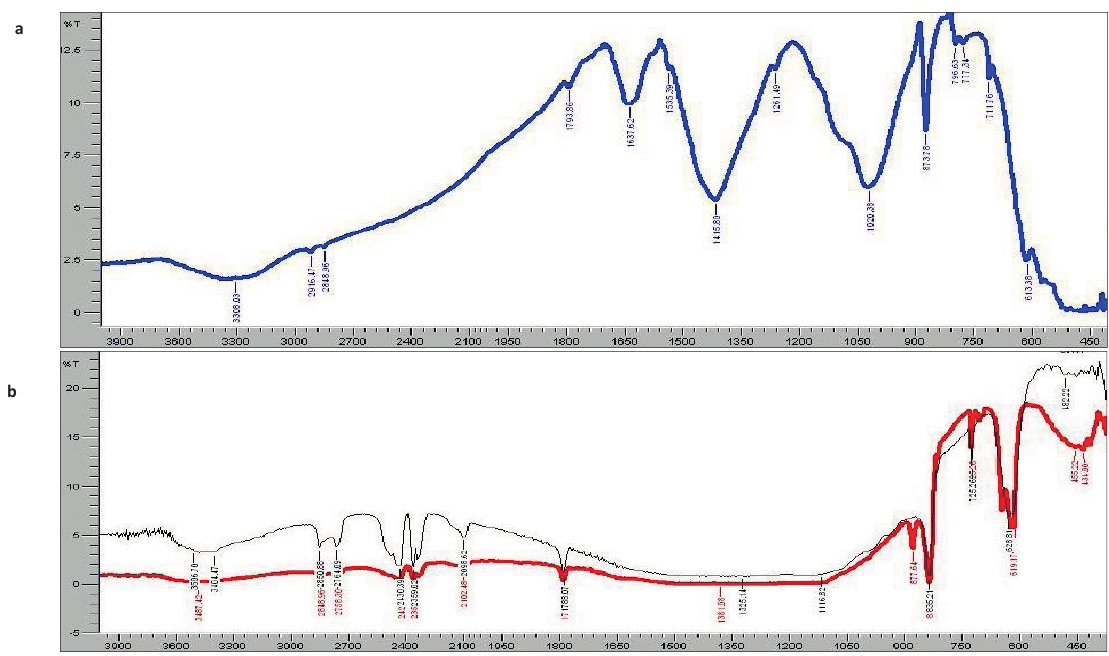
Fig. 3 Figure 3: a) FTIR spectrum P. cerasifera fruit extract and b) FTIR spectra overlay of P. cerasifera fruit extract mediated ZnO nano falcate calcined at 200 and 400 . ℃